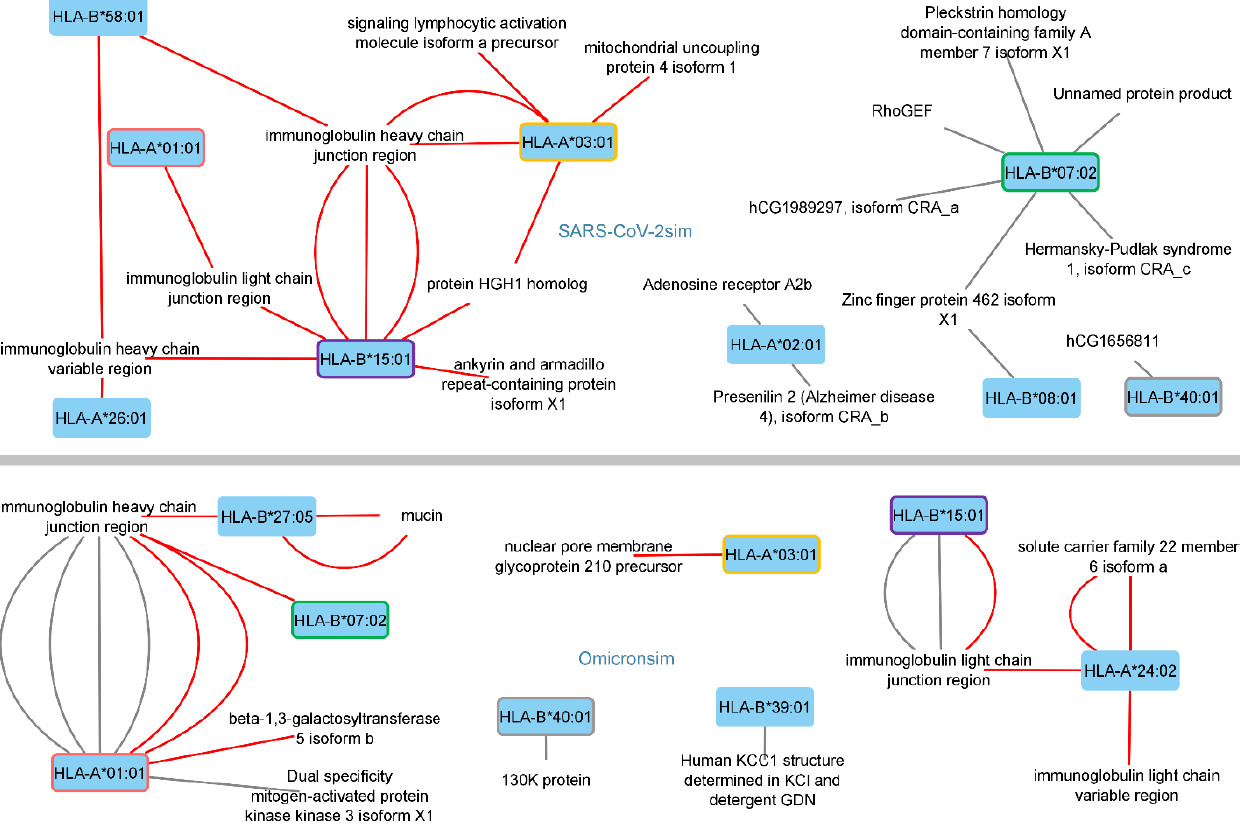
Figure 2. Networks of human proteins with virus-similar peptides at the mutation sites of interest and the HLA alleles, to which they had affinity. Alleles are connected to the proteins through the peptide of that protein mimicking the viral peptide and with strong affinity to the connected allele, such as the mimicked viral peptide. The top part displays those of human proteins with SARS-CoV-2 similar (SARS-CoV-2sim) peptides. The bottom part displays those of human proteins with Omicron similar (Omicronsim) peptides. Alleles at both parts are encircled with the same color indicator of that allele. Other alleles are not encircled. Red edges (i.e., connections) belong to the human proteins sharing 6mers with SARS-CoV-2 sequences at Omicron 21L-specific mutation sites (on top ), and to the human proteins sharing 6mers with sequences containing Omicron 21L-specific mutations (at the bottom ). Affinity refers to weak-binder/strong-binder/epitope (WB/SB/E). (Ring Finger Protein 10 was identified as an unnamed protein product in the Blastp alignment document).